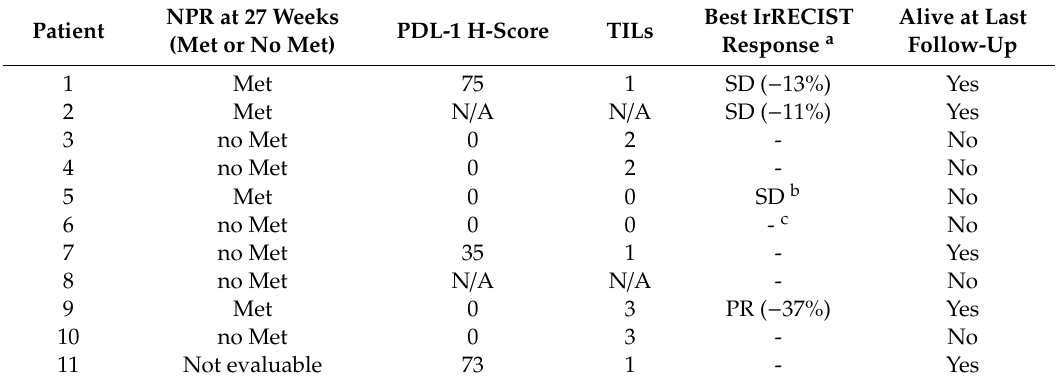
Table 3. Correlations between PDL-1 H-score, TILs, radiographic response, and survivorship in